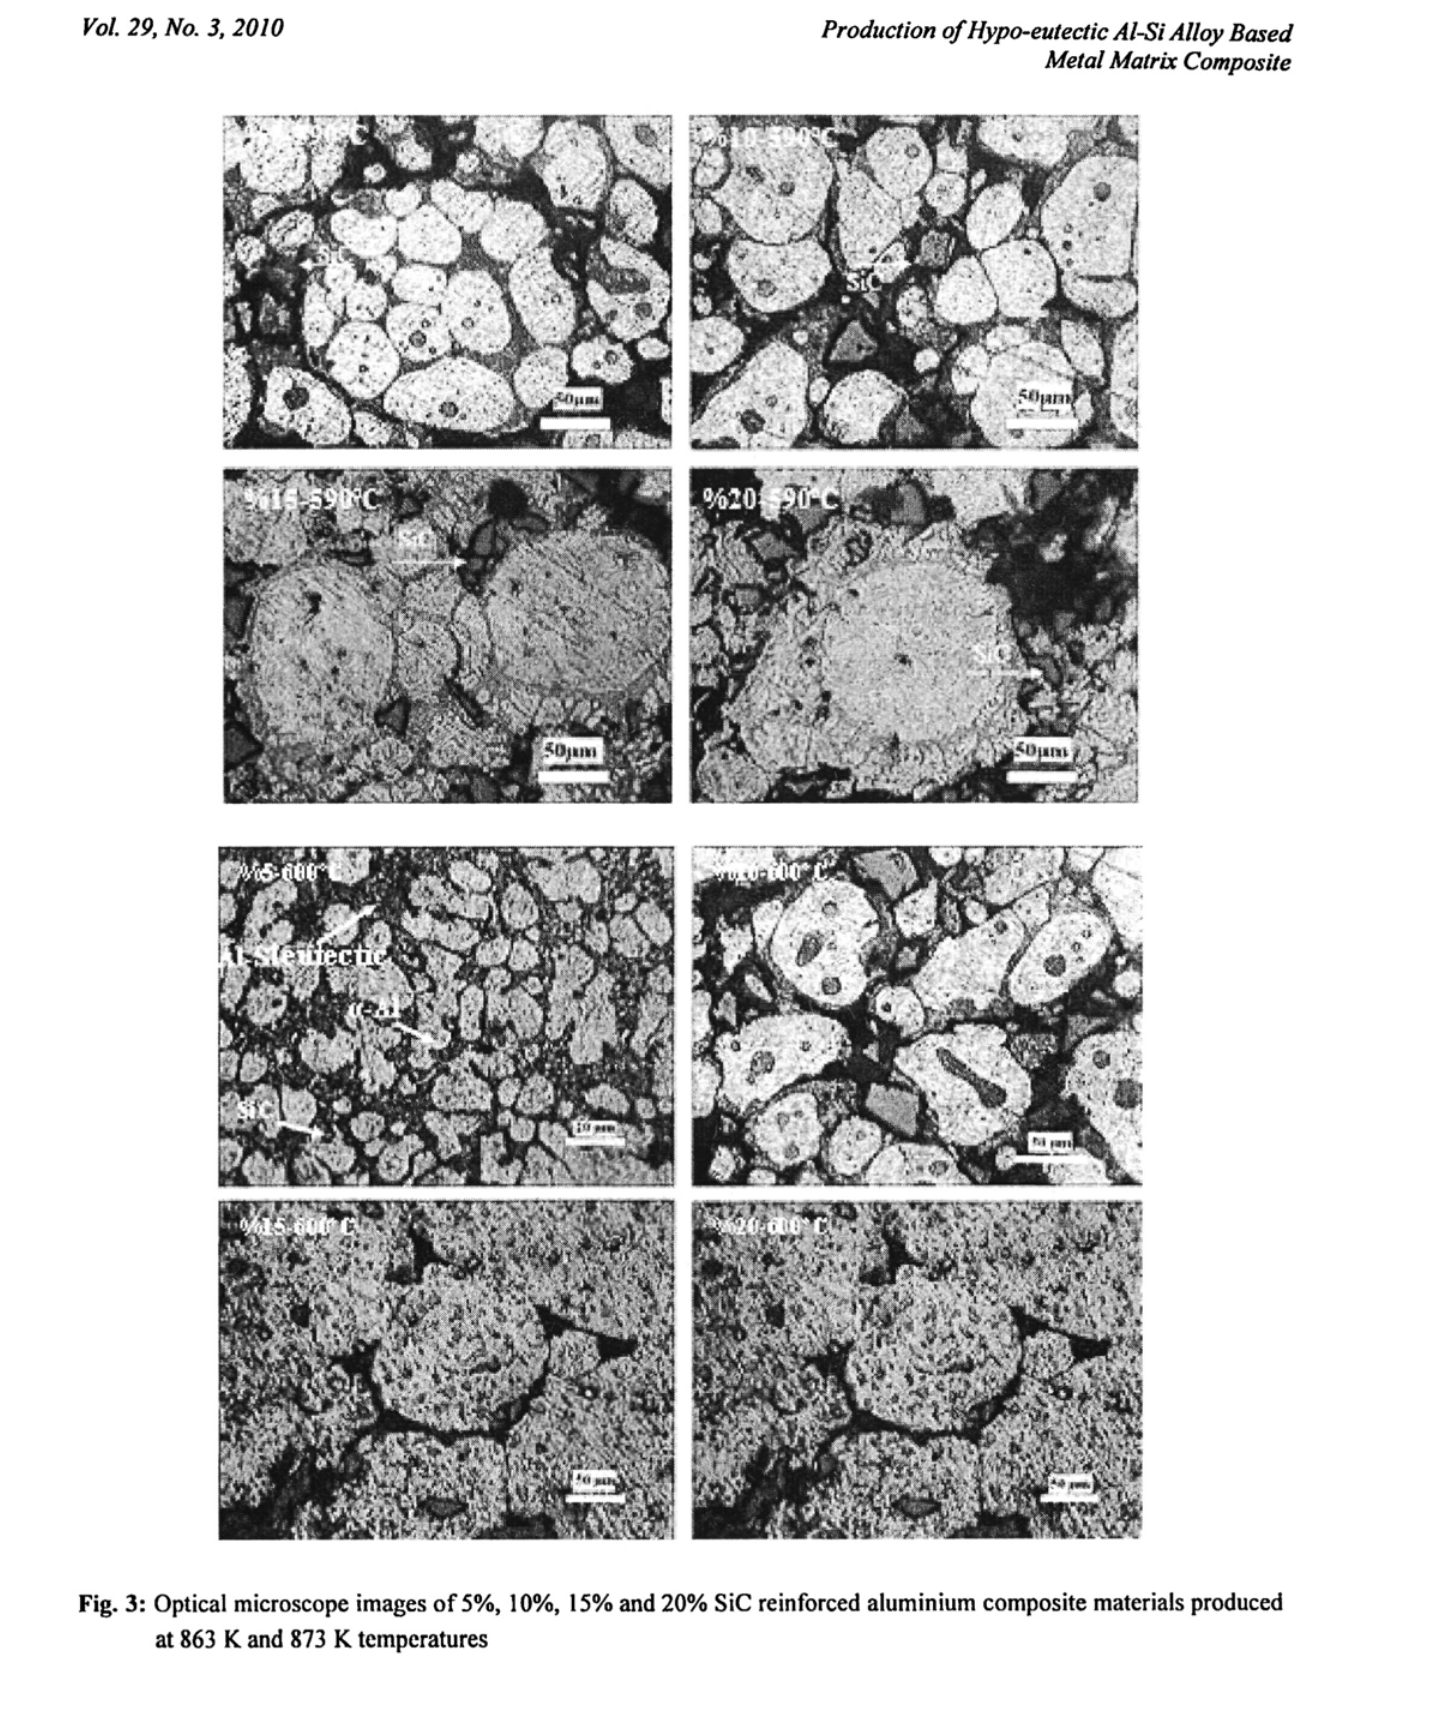
Fig. 3: Optical microscope images of 5%, 10%, 15% and 20% SiC reinforced aluminium composite materials produced at 863 K and 873 K temperatures